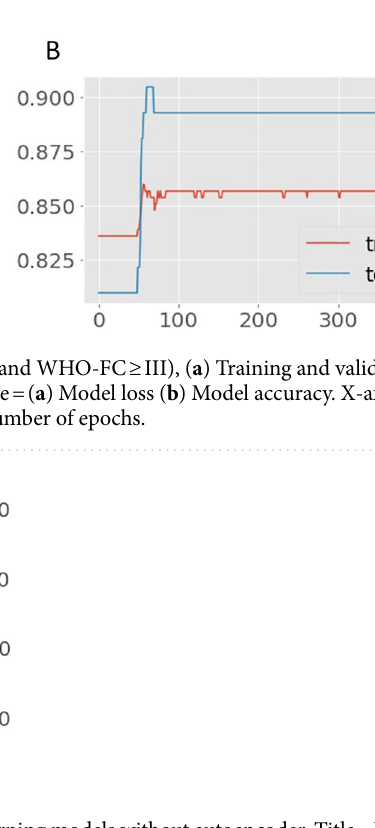
Figure 6. Confusion Matrix for both deep learning models without autoencoder. Title = Deep learning Confusion Matrix. X-axis (Left) = True Labels (upper row = Survivors, lower row = Non-survivors). X-axis (Right) = Number of cases. Y-axis = Predicted Labels (right column = Survivors, left column =